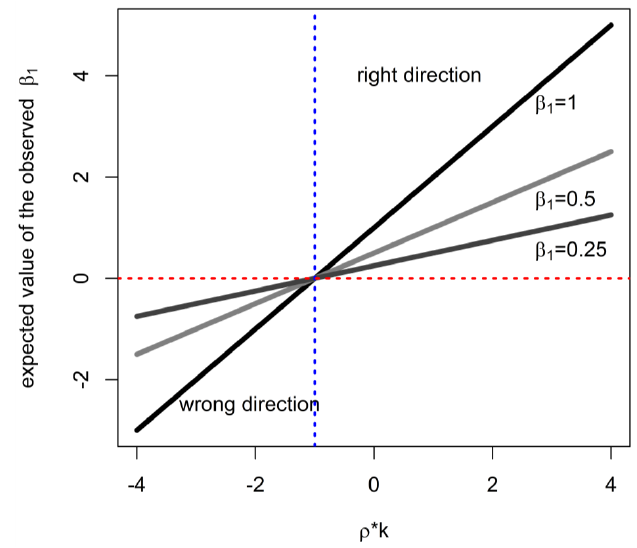
Figure 1. The expected direction of the apparent association with duration of exposure, as a function of correlation of intensity and duration (ρ), ratio of variances of intensity and duration (k), and strength of causal effect (β 1 ).